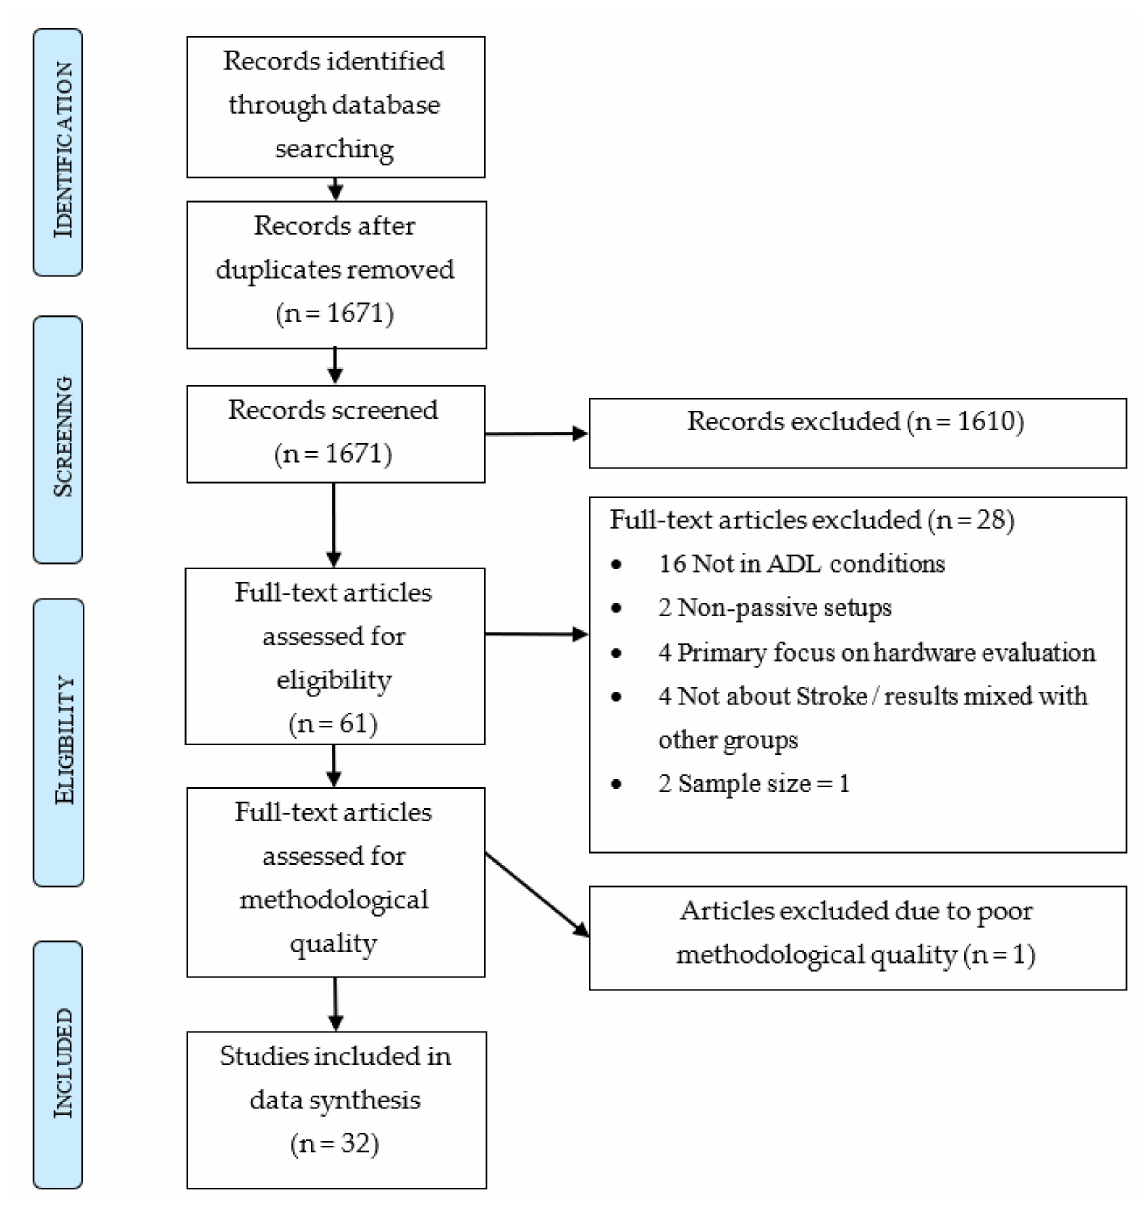
Figure 1. PRISMA